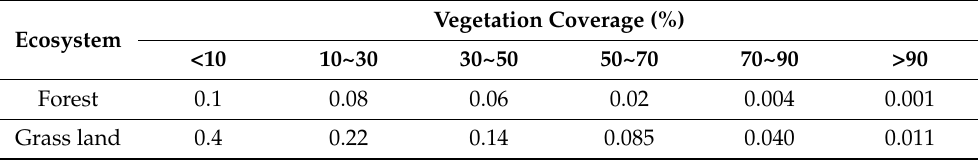
Table 5. COG of different land cover